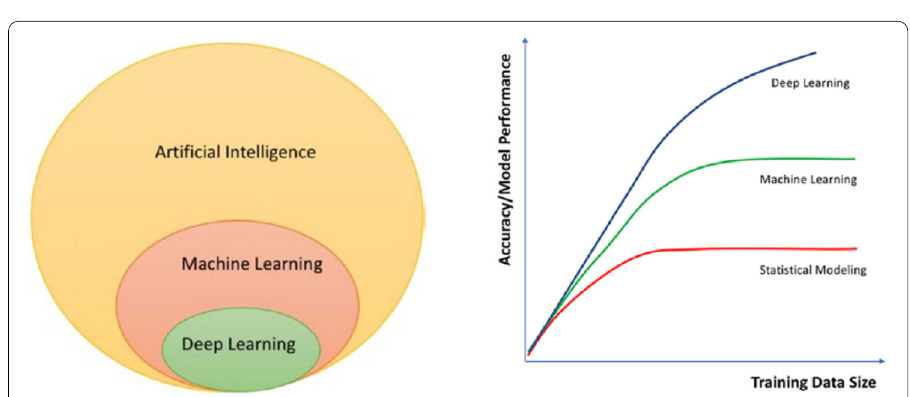
Fig. 2 Artificial Intelligence. Artificial Intelligence, Machine Learning and Deep Learning, see [7]